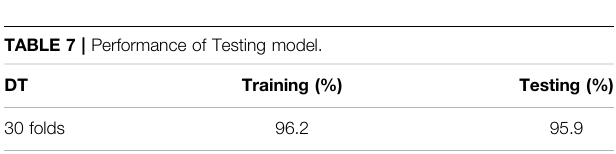
TABLE 7 | Performance of Testing